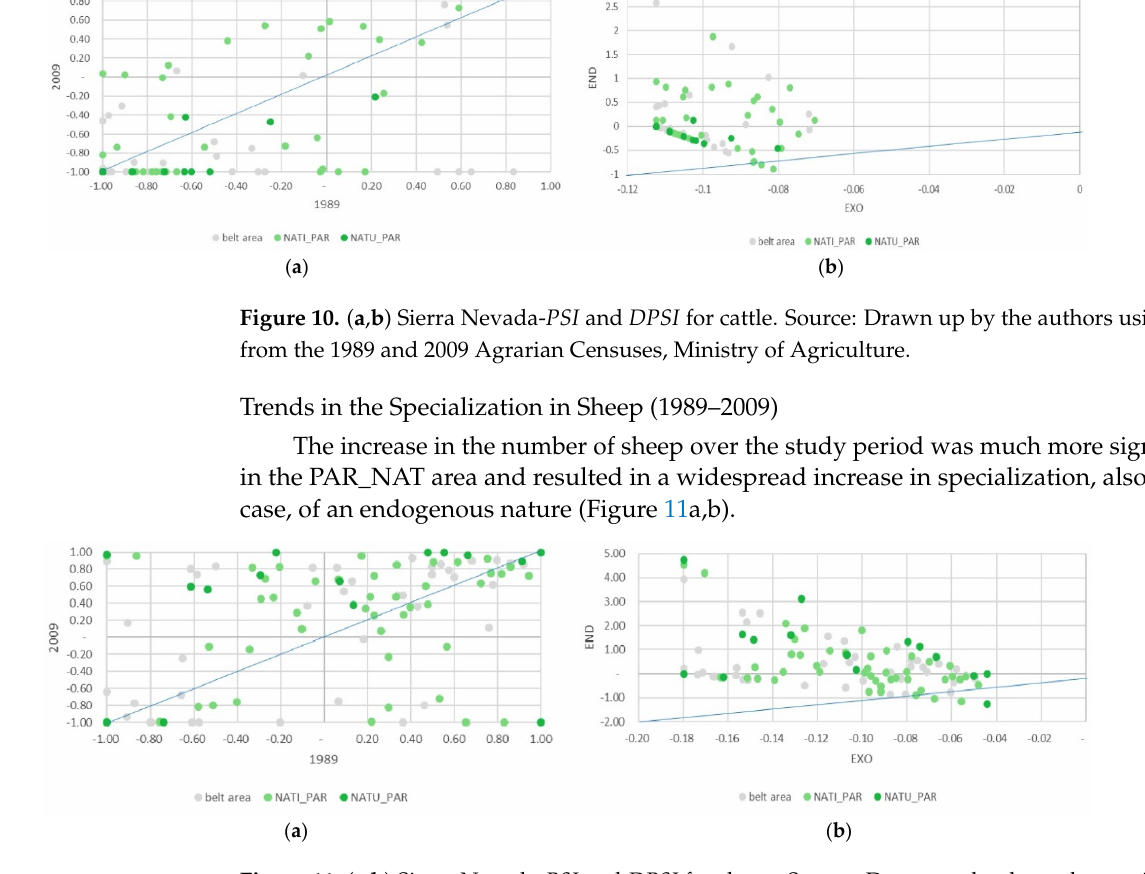
Figure 11. ( a , b ) Sierra Nevada- PSI and DPSI for sheep. Source: Drawn up by the authors using data from the 1989 and 2009 Agrarian Censuses, Ministry of Agriculture. Trends in the Specialization in Goats (1989–2009)